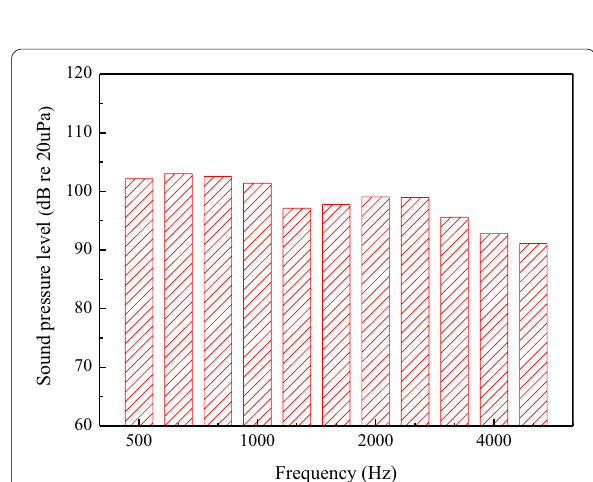
Figure 29 Sound pressure spectrum of the exterior sidewall